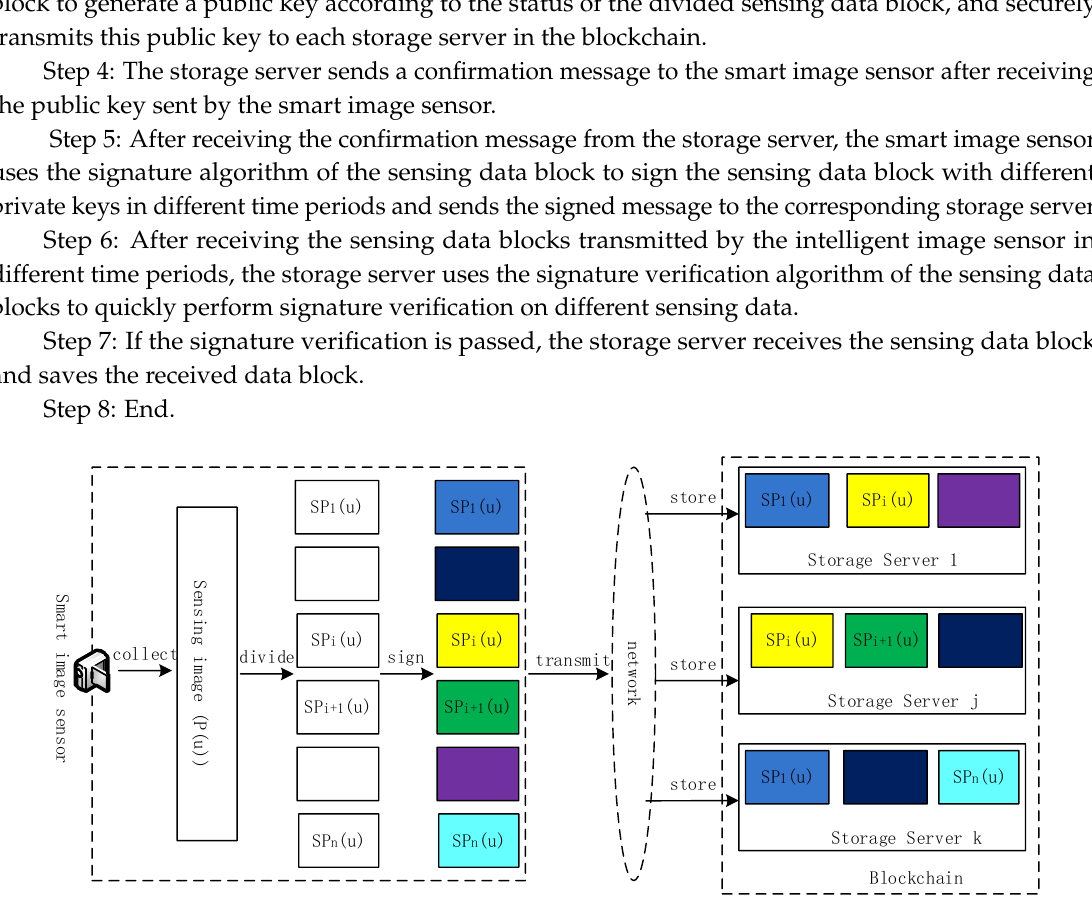
Figure 1. Schematic diagram of secure transmission and storage of blockchain-oriented sensory images in the IoT. Table 1. Symbols and